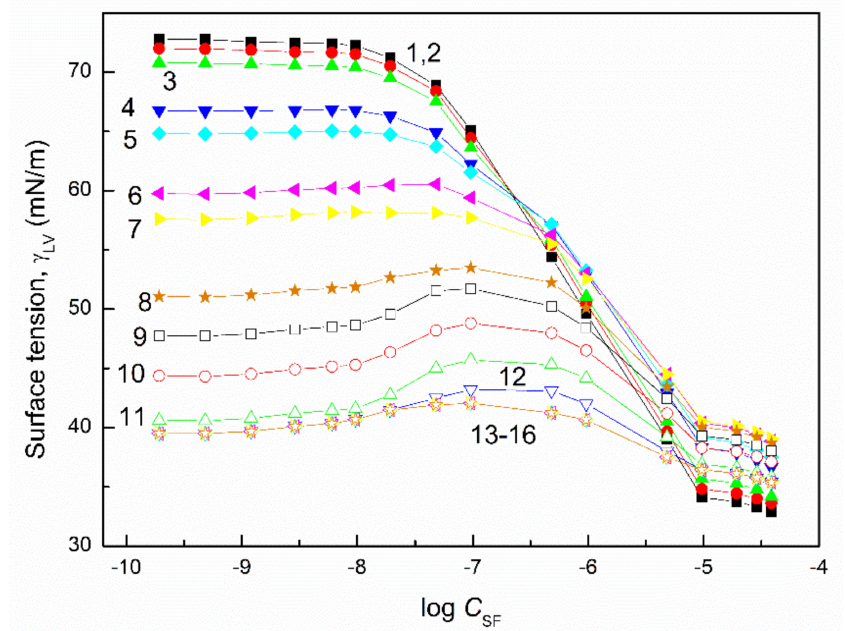
Figure 5. A plot of the surface tension ( γ LV ) of the aqueous solution of the SF and TX165 mixture vs. the logarithm of the SF concentration ( C SF ). Curves 1 − 16 correspond to the constant TX165 concentration equal to 1 × 10 − 8 , 5 × 10 − 8 , 1 × 10 − 7 , 5 × 10 − 7 , 1 × 10 − 6 , 5 × 10 − 6 , 1 × 10 − 5 , 5 × 10 − 5 , 1 × 10 − 4 , 2 × 10 − 4 , 4 × 10 − 4 , 6 × 10 − 4 , 8 × 10 − 4 , 0.001, 0.002, and 0.004 mole/dm 3 ,